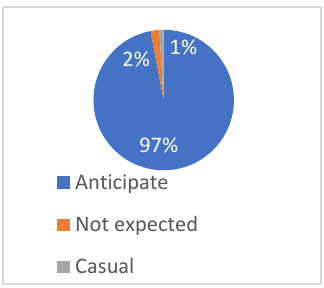
Figure 15. Analysis of willingness to use interactive technology .